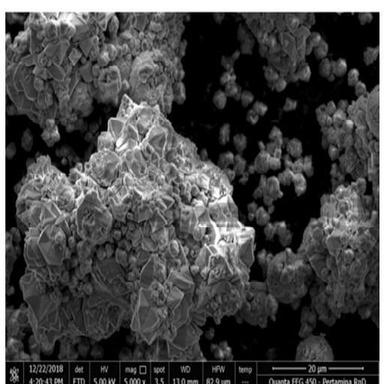
SEM of NaY zeolite from synthetic material